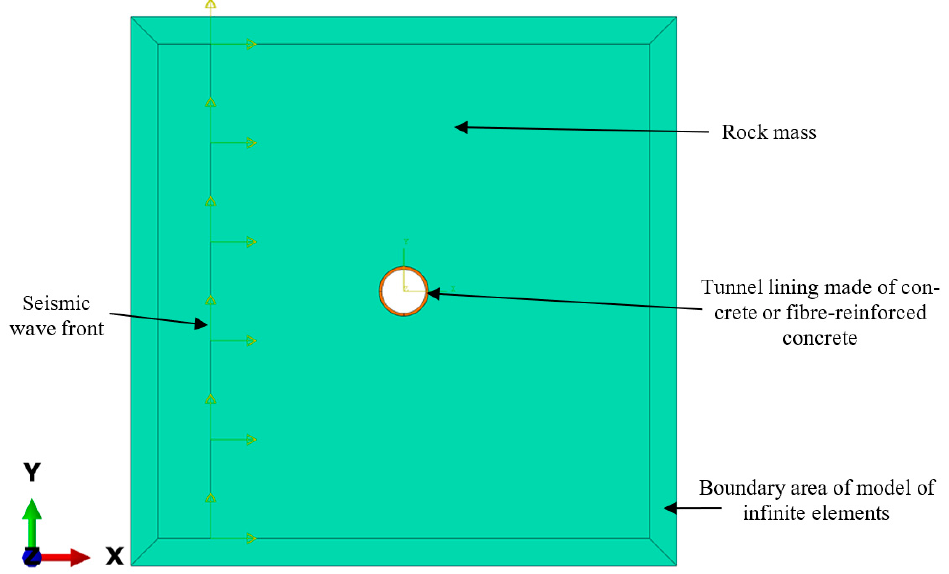
Table 3. Physical and mechanical properties of rocks [15].